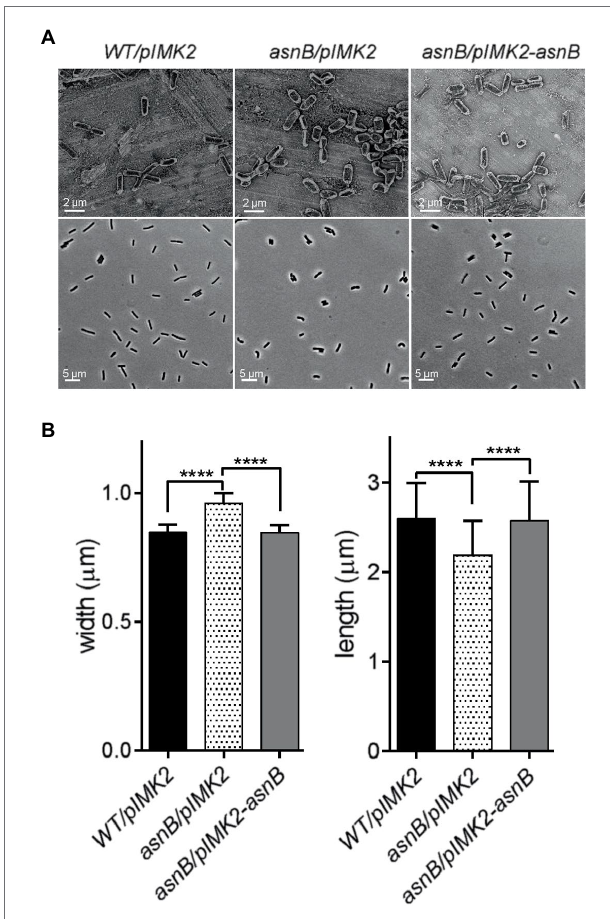
FIGURE 2 | Analysis of cell morphology of the L. monocytogenes asnB mutant grown to exponential phase (OD 600 = 1) at 30 ° C. (A) SEM (top row) and phase contrast light microscopy images (bottom row) of WT/pIMK2 , asnB/pIMK2 , and asnB/pIMK2-asnB strains. (B) Analysis of cell dimensions of the same strains from phase contrast images using MicrobeTracker software (Sliusarenko et al., 2011). The data represent mean ± SD of cell length and width; n = 300. ****, p < 0.0001 by two-tailed student’s t -test.